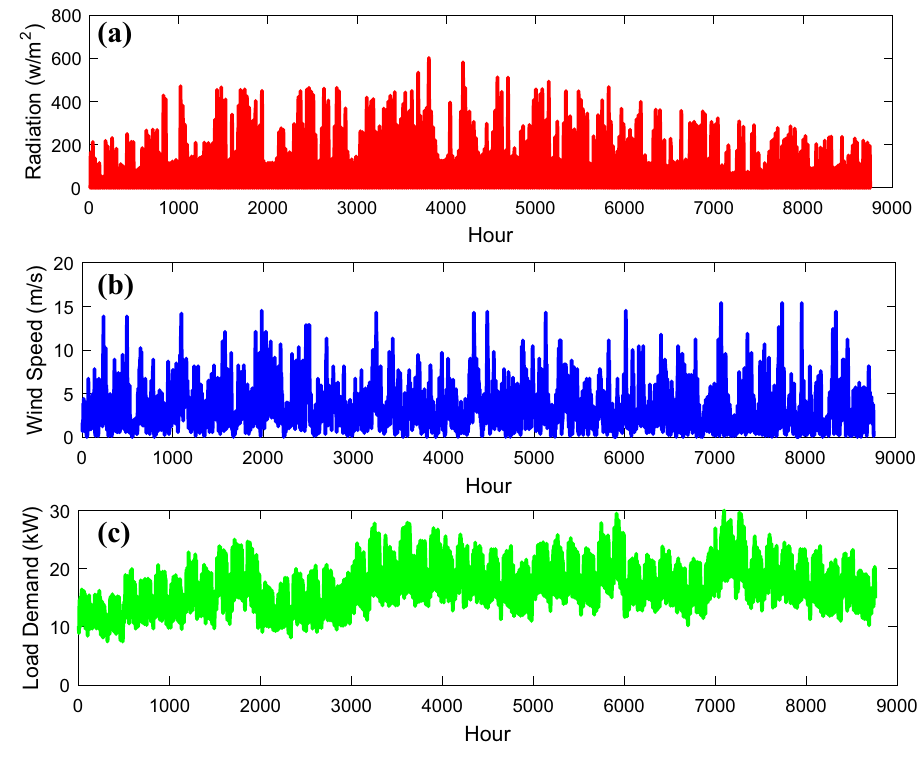
Table 1. The coding of the problem is done in the MATLAB area.